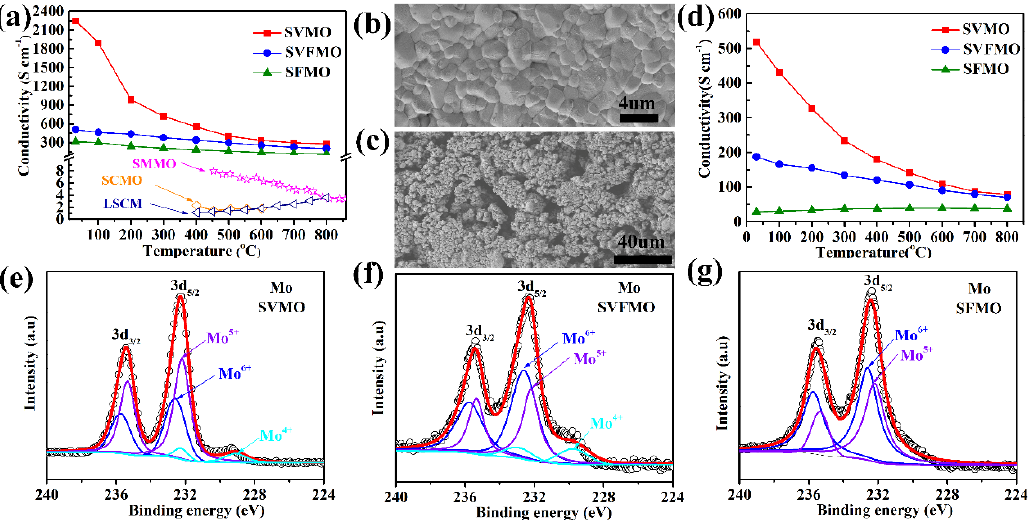
Figure 3. Temperature dependence of electrical conductivity of ( a ) the dense bar and ( d ) the porous bar anode materials. SEM images of SVFMO: ( b ) the dense bar and ( c ) the porous bar. XPS spectra of Mo 3d to evaluate the valence states of Mo elements in ( e ) SVMO, ( f ) SVFMO and ( g ) SFMO. The XPS were used to detect the possible valence states of V, Fe and Mo in the three samples. The mixed valence states of the elements were evaluated by fitting the XPS data. First, for the XPS of Fe 2p signals in SVFMO and SFMO (Figure S1), the peaks at the